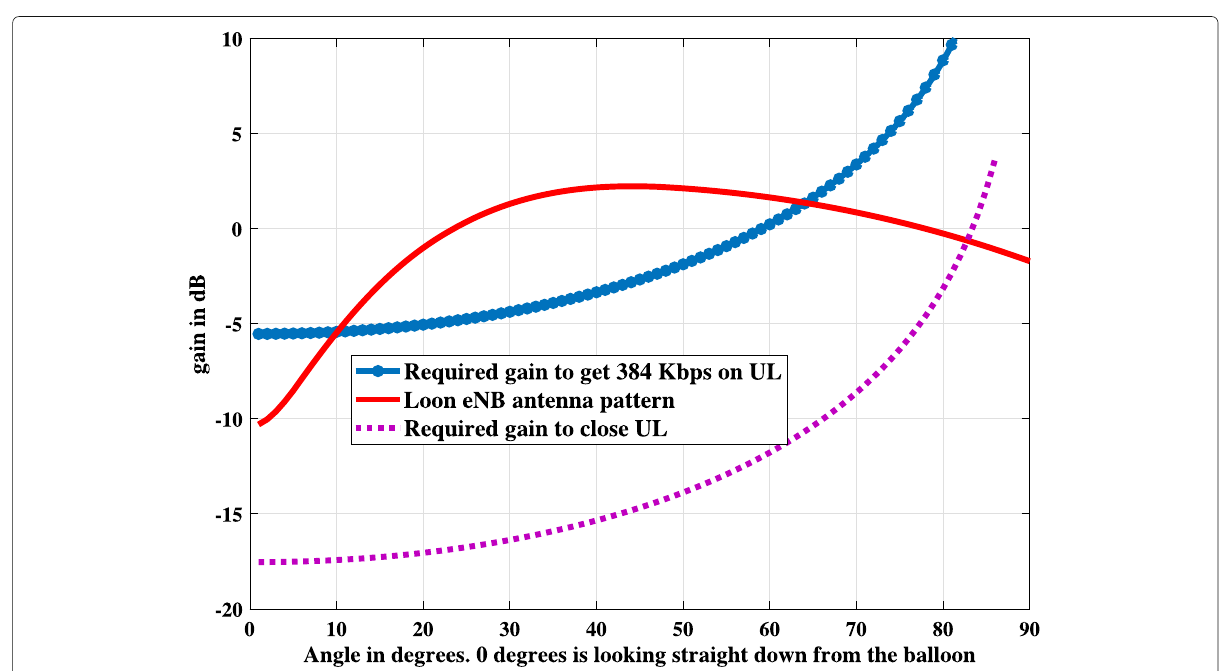
Fig. 1 Loon eNB prototype antenna